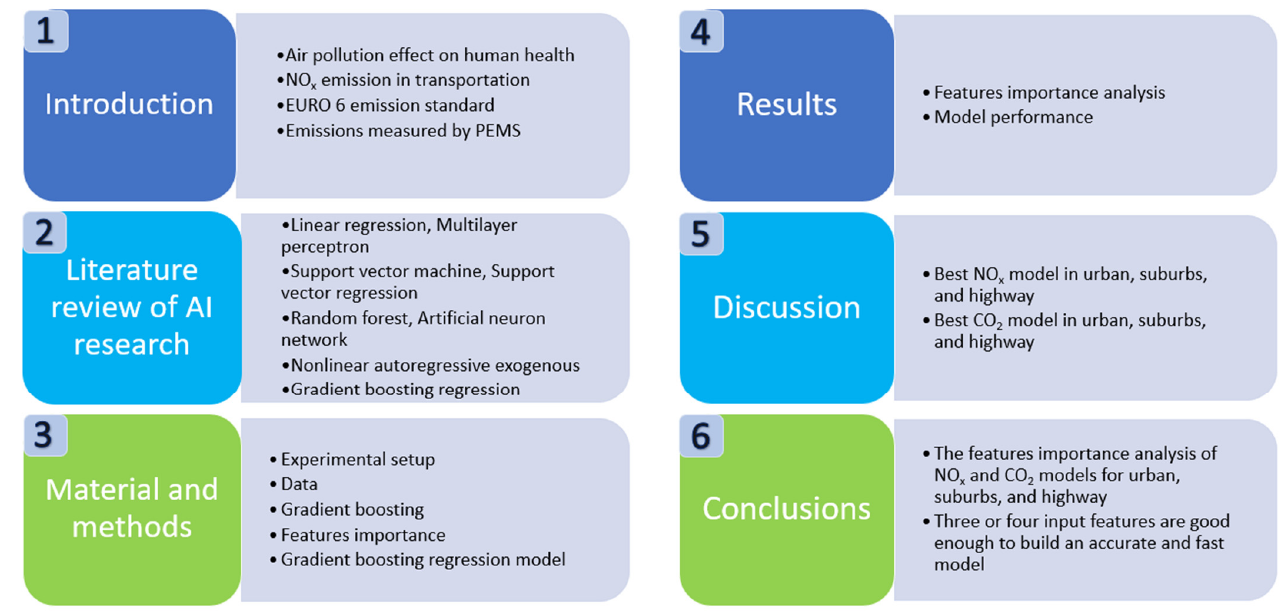
Figure 1. Structure of this study.